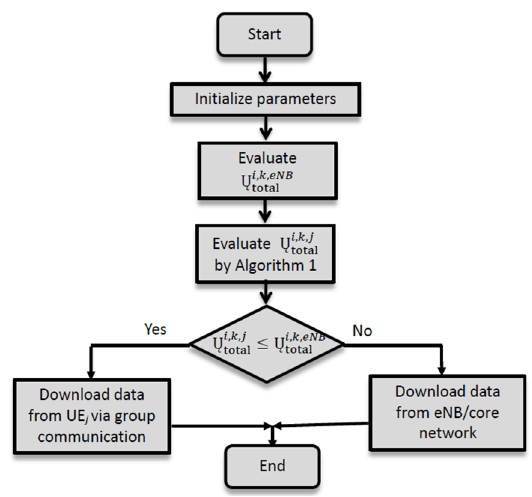
Figure 7. Decision procedure of group header.